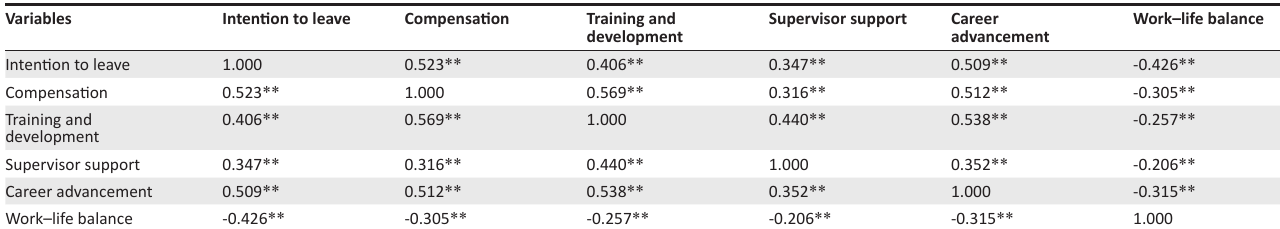
TABLE 2: Pearson